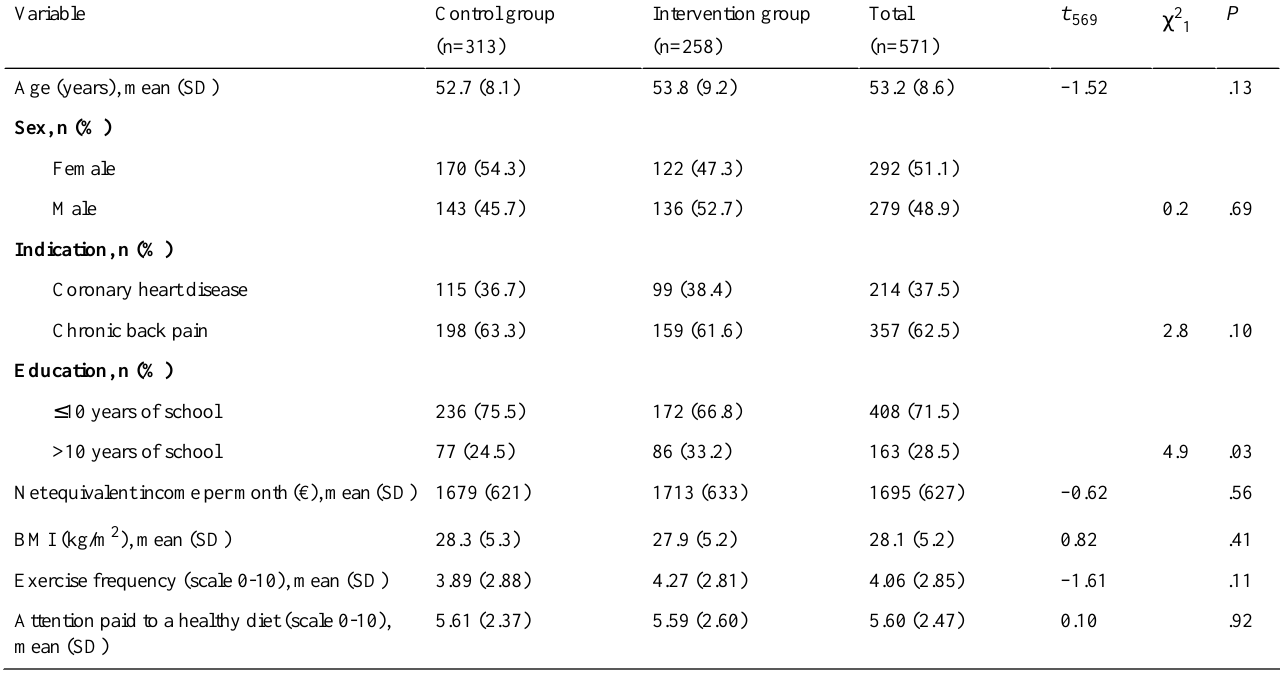
Table 1. Baseline characteristics—intention-to-treat analysis.